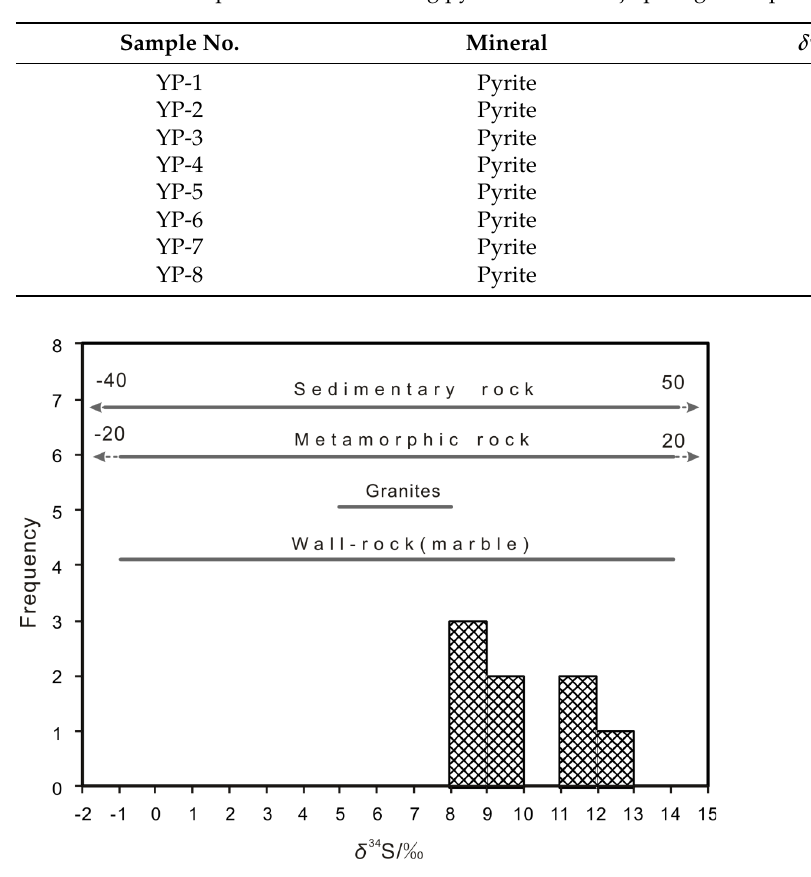
Figure 5. Sulfur isotope composition from the ore-bearing pyrite of the Lijiapuzi deposit sedimentary rocks, metamorphic rocks, granites, and wall − rock (marble) data from [43].